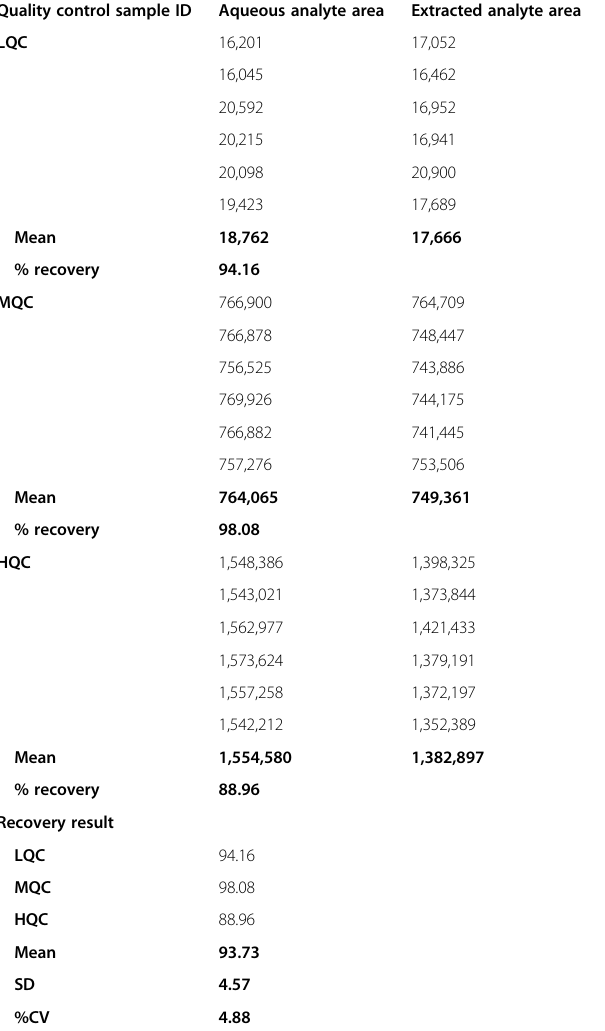
Table 11 Recovery of bexarotene Quality control sample ID